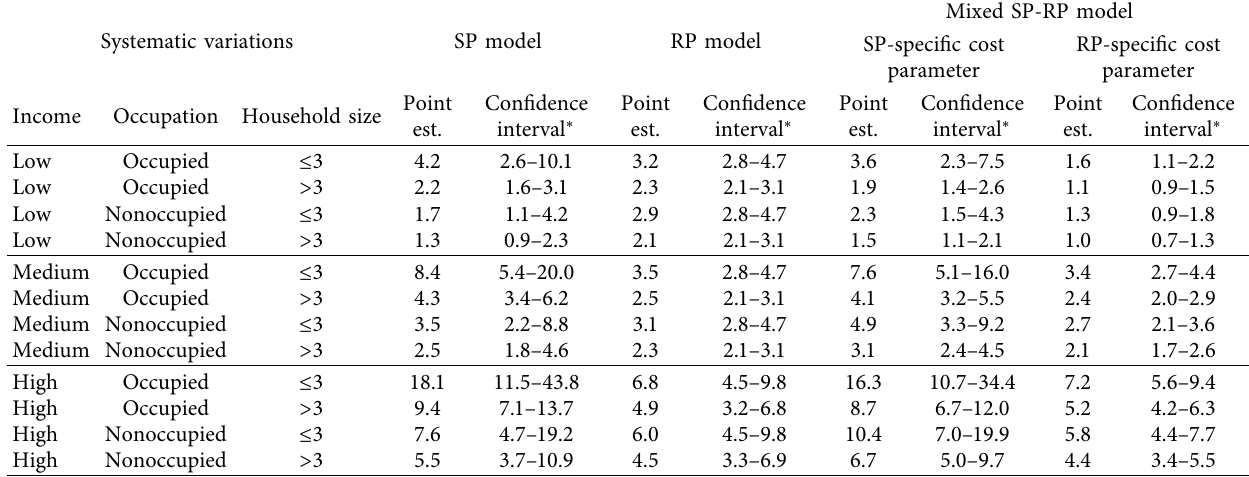
Table 6: Subjective values of time